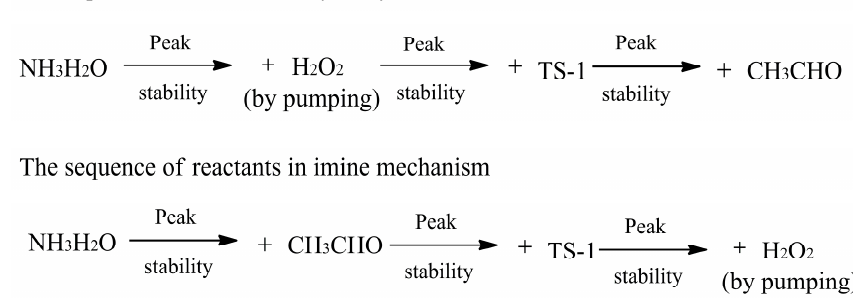
Figure 8. The different sequences of reactants in two mechanisms.